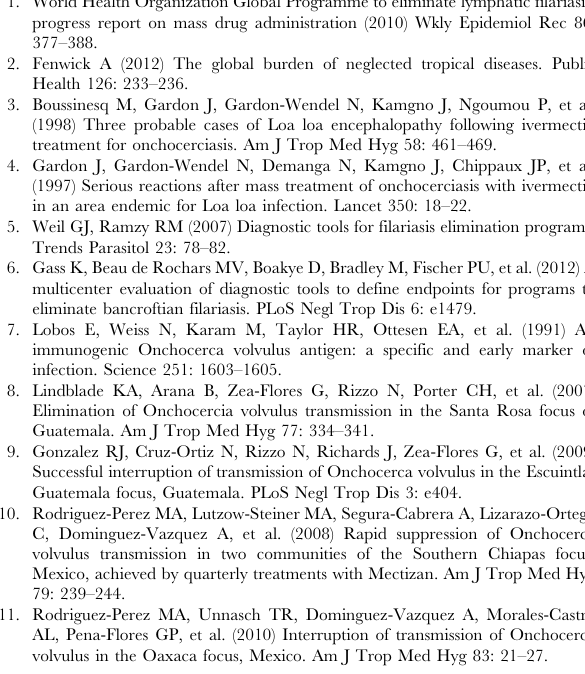
Table S1 Annotated Excel table ouput from dCAS of 19 antigens used as potential targets for Wuchereria